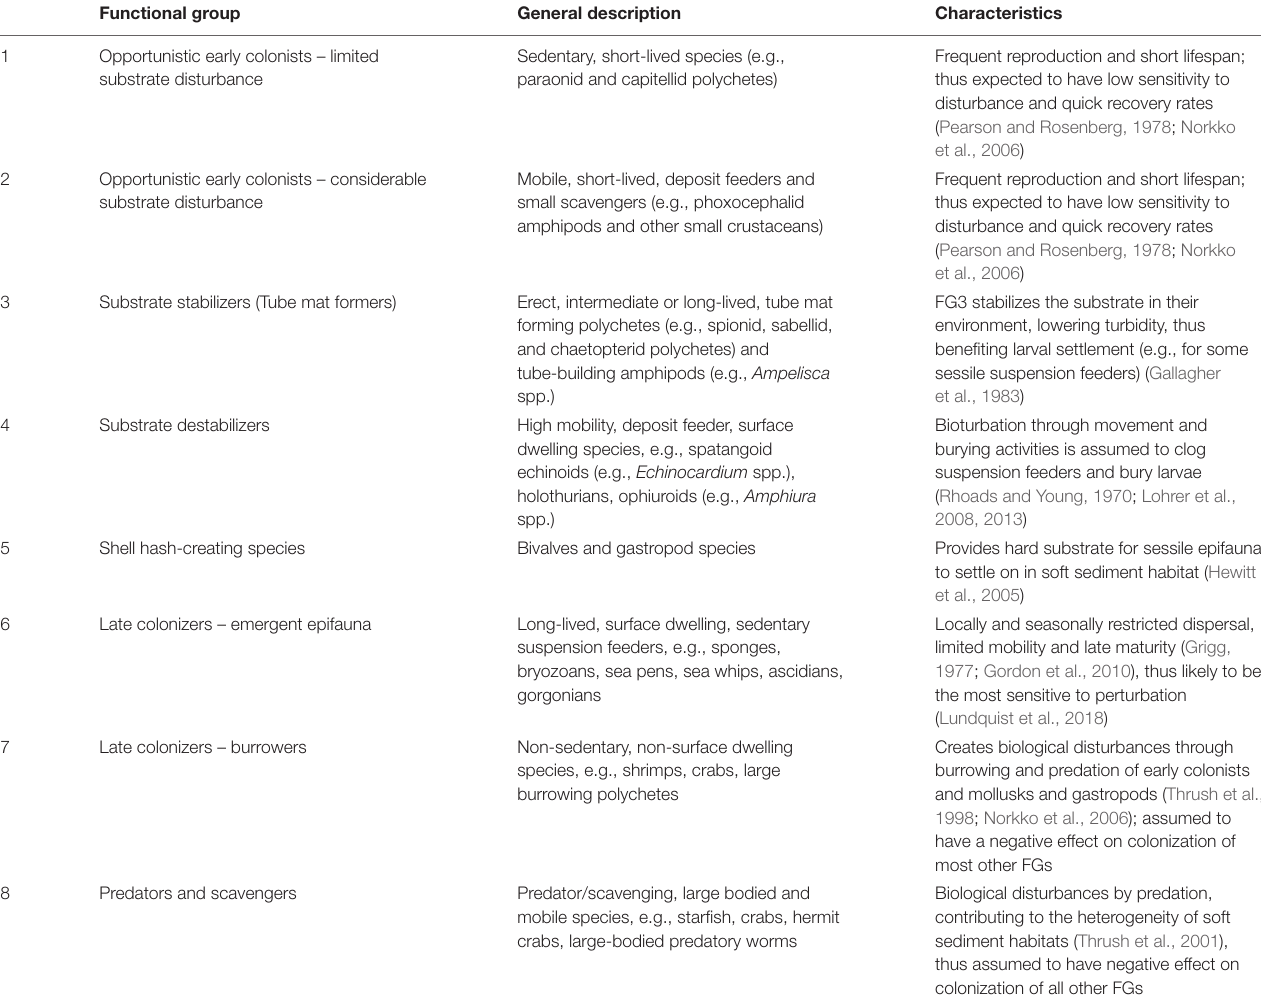
TABLE 1 | General description of fauna classified under functional groups (FG) included in the model simulations. Functional